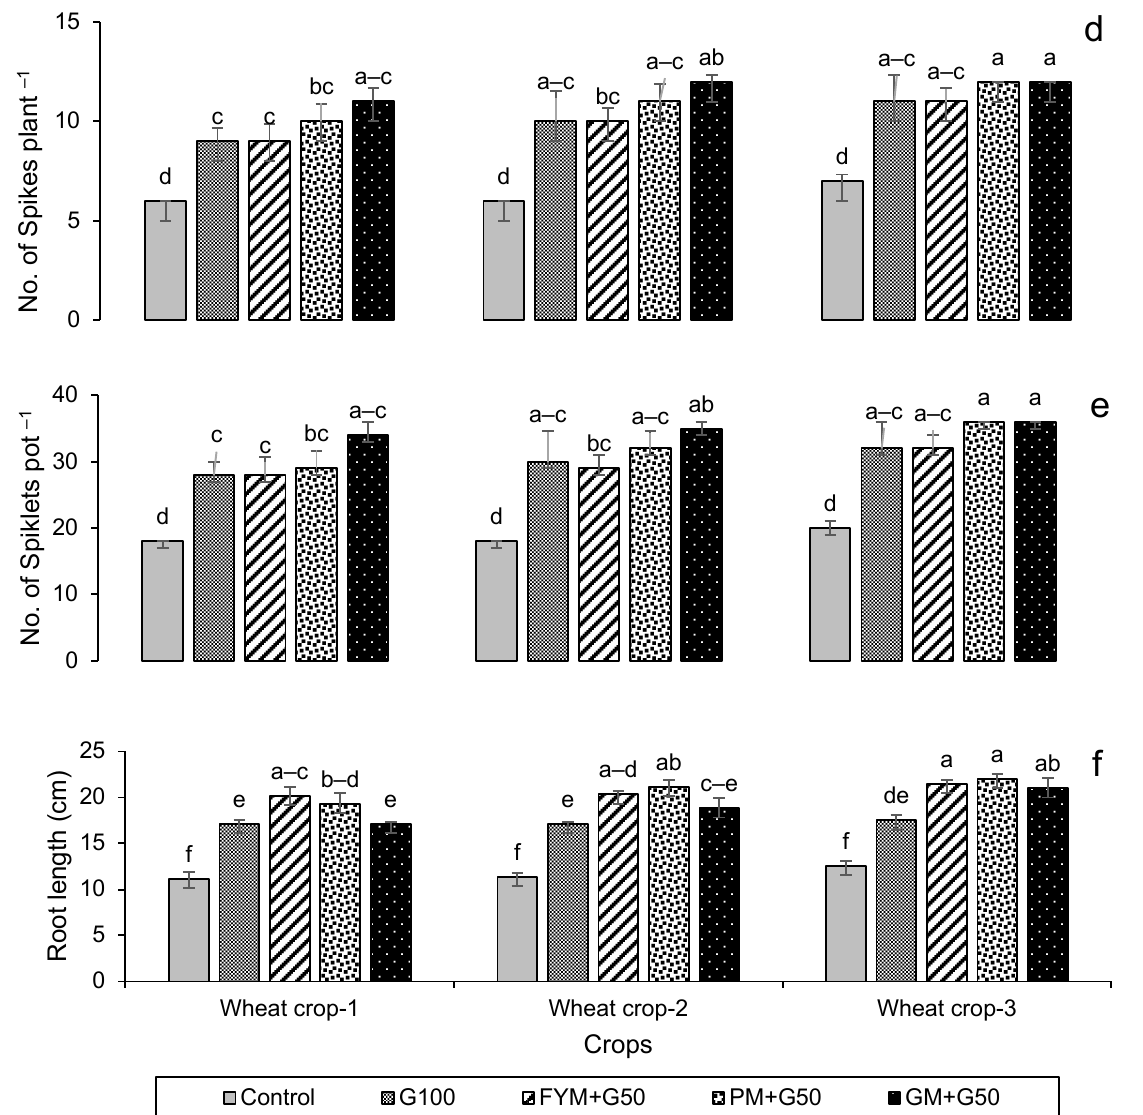
Figure 5. Impacts of different treatments on ( a ) leaves, ( b ) shoots and ( c ) root fresh and dry weights, ( d ) no. of spikes, ( e ) no. of spikelets and ( f ) root length of wheat. Error bars represent the standard error ( n = 3). Different letters indicate statistical difference (LSD, p < 0.05). For maize, the highest leaf dry weight was in year 2 in the treatment FYM + G50, with a 56% increase over the control (Figure 6a), while shoot and root dry weights were highest in year 2 for FYM + G50 (a 49% increase over the control) and in year 3 for GM + G50 (a 114% increase over the control) (Figure 6b,c). In the maize crop, the maximum increase in root length (+90%) was recorded in the treatment PM + G50 in year 3 (Figure 6d). The wheat and maize crop yields showed a significant variation with treatment and year (Figure 7). The maximum wheat yield in the year 3 treatment FYM + G50 showed a 51% increase over the control (Figure 6a), while the highest maize yield was a 49% increase in GM + G50 in year 3 (Figure